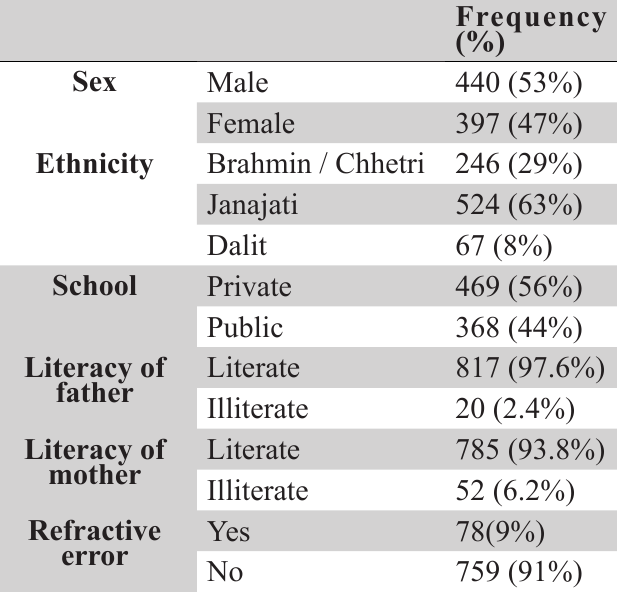
Table 1. Demographic profile of refractive